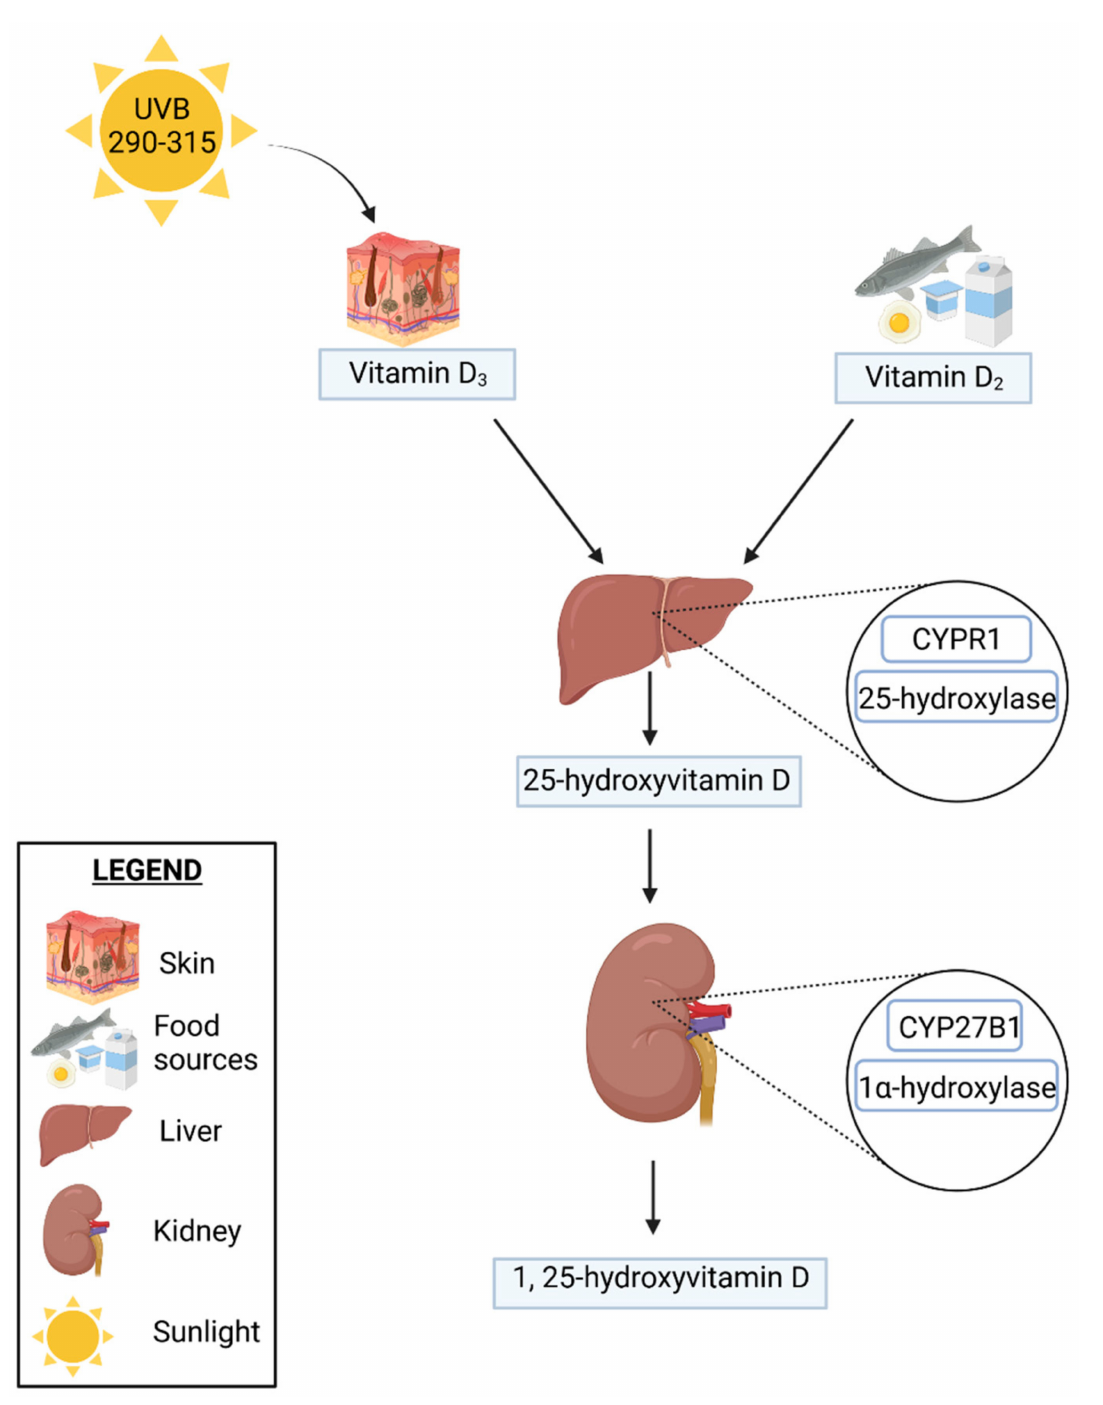
Figure 1. The scheme of vitamin D